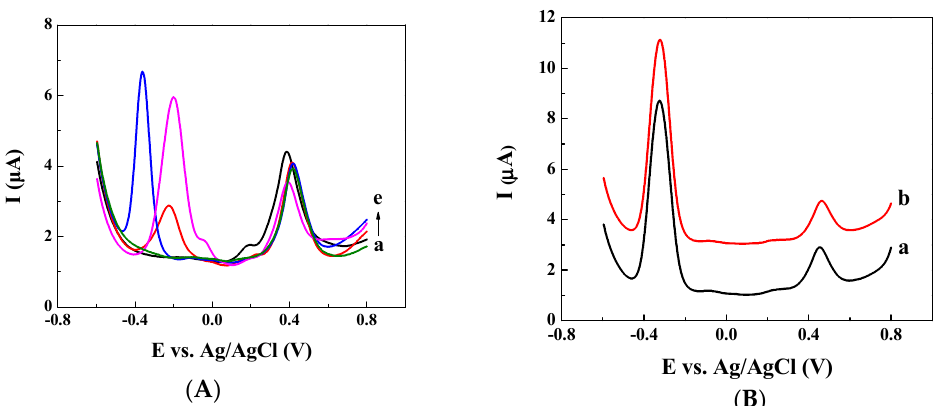
Figure 2. ( A ) SWV curves of 25 µ M CBL in 0.1 M PBS (pH 7.0) together with various reference probes. (a) without probes; (b) ferrocene (Fc); (c) methylene blue (MB); (d) thionine (Th); (e) Nile blue (NB). ( B ) SWV curves of 25 µ M CBL and 5 µ M NB in di ff erent adding order: (a) CBL, NaOH, NB; (b) CBL, NB, NaOH.